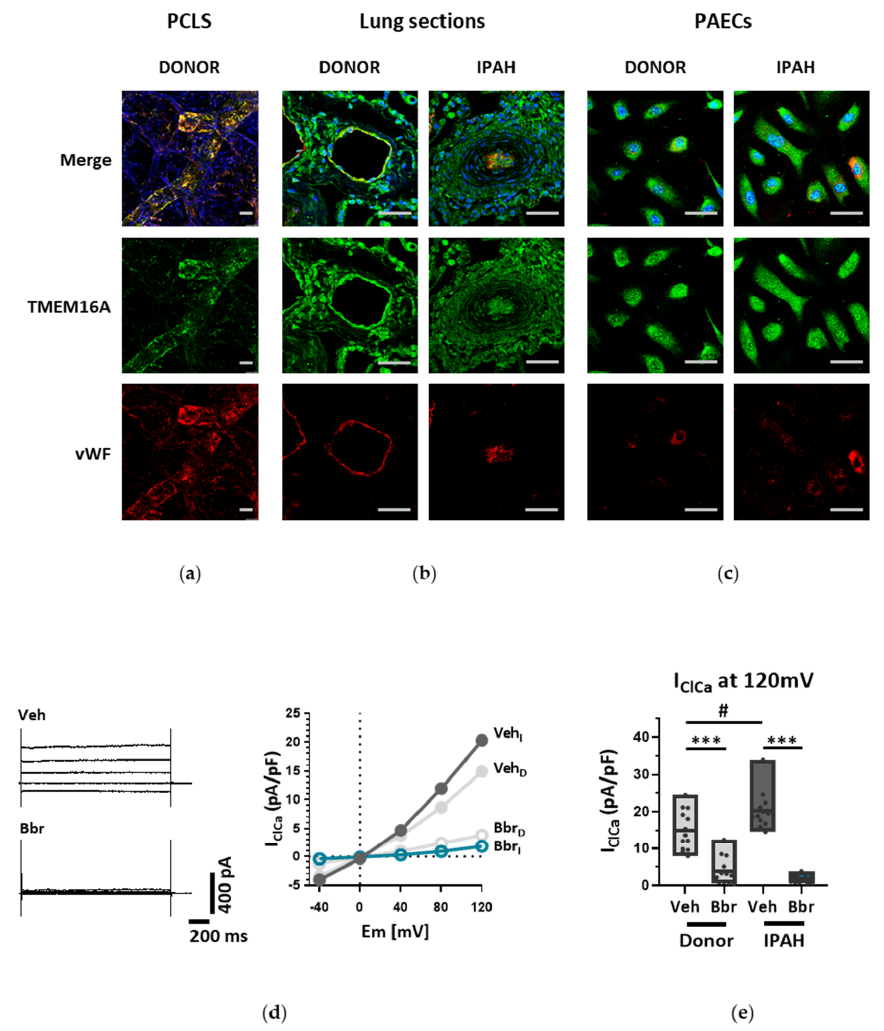
Figure 2. TMEM16A accounts for increased Ca 2 + -activated Cl − current in IPAH PAECs. Immunofluorescence staining of ( a ) 3D precision cut lung slices (PCLS), ( b ) lung sections and ( c ) PAECs obtained from healthy donor lungs and patients su ff ering from IPAH (BP = antibody blocking peptide, scale bar = 50 μm for PCLS, 50 μm for PAECs and 50 μm for lung sections). ( d ) The effect of Bbr on representative whole-cell I ClCa traces (left) and normalized current-voltage relationships (right) measured with voltage clamp in donor and IPAH PAECs (Veh I / Bbr I = IPAH PAECs perfused with vehicle or Bbr; Veh D / Bbr D = donor PAECs perfused with vehicle or Bbr). ( e ) Comparison of the Ca 2 + -activated Cl − current density of donor and IPAH PAECs at 120 mV. Figures were generated with n = 12–13 cells from at least N = 4 patient samples. # p < 0.01, *** p < 0.0001, ANOVA with Bonferroni post-hoc test, data are presented as mean ±